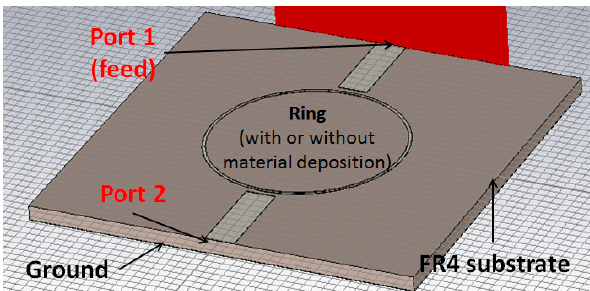
Figure 4: Mockup of the numerical setup following details given in Fig. 3.